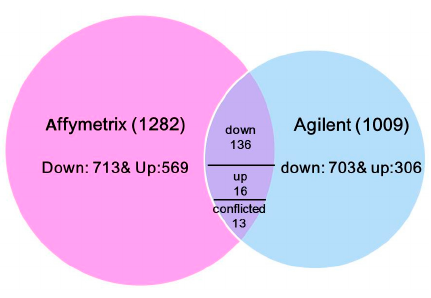
Figure 1. A Venn diagram of differential expressed genes and their common genes across two microarray datasets.